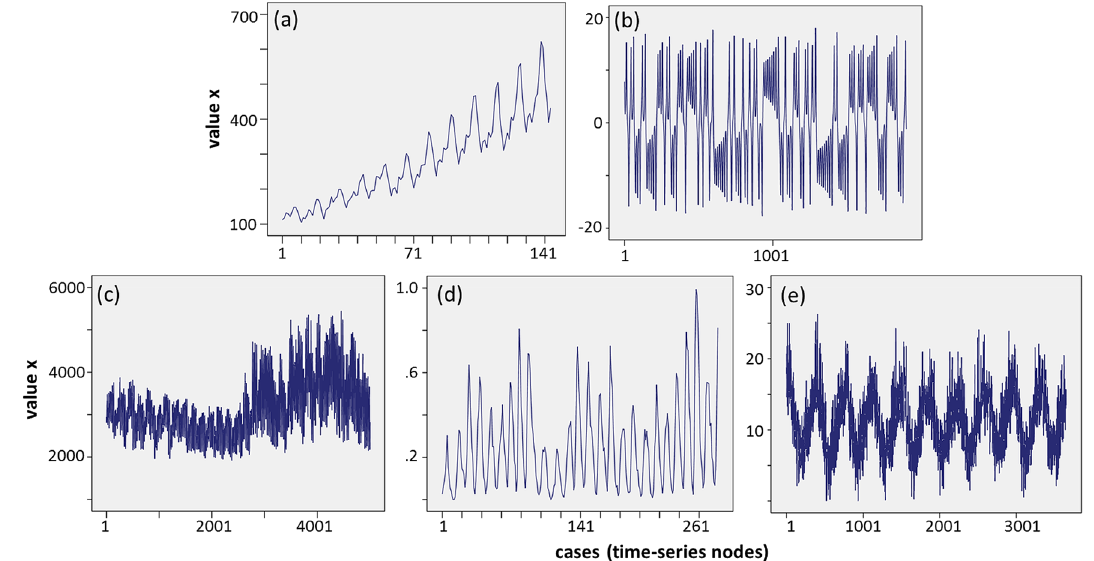
Figure 5. The source (reference) time-series considered in the analysis represent distinctive different patterns, where ( a ) is an air-passengers time-series with linear trend ( X a : 144 cases, including the monthly totals of a US airline passengers for the period 1949 to 1960), ( b ) is the typical Lorentz chaotic time-series ( X b : 1900 cases, created from the Lorenz equations, on standard values sigma = 10.0, r = 28.0, and b = 8/3), ( c ) is a part ( X c : 5000 cases) of a broader stationary time-series including estimated energy consumption, in Megawatts (MW), for the Duke Energy Ohio/Kentucky, ( d ) is a periodical time-series ( X d : 280 cases, including wolfer sunspot numbers for the period 1770 to 1771), and ( e ) is a cyclic time-series ( X e : 3650 cases, including daily minimum temperatures in Melbourne, Australia, for the period